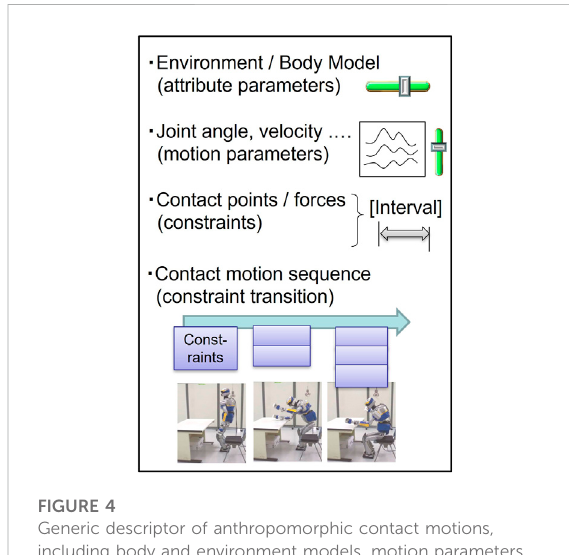
FIGURE 5 Continual learning of the contact motion network unifying model-based and machine learning approaches. Cost function of contact motion is fi rst identi fi ed based on ef fi cient inverse optimization bene fi ting from analytical gradient computation. By the abstract expression of contact motion with the combination of generic dynamics description and cost function, interrelation of the contact sequence can be learned without embedding known dynamic models.